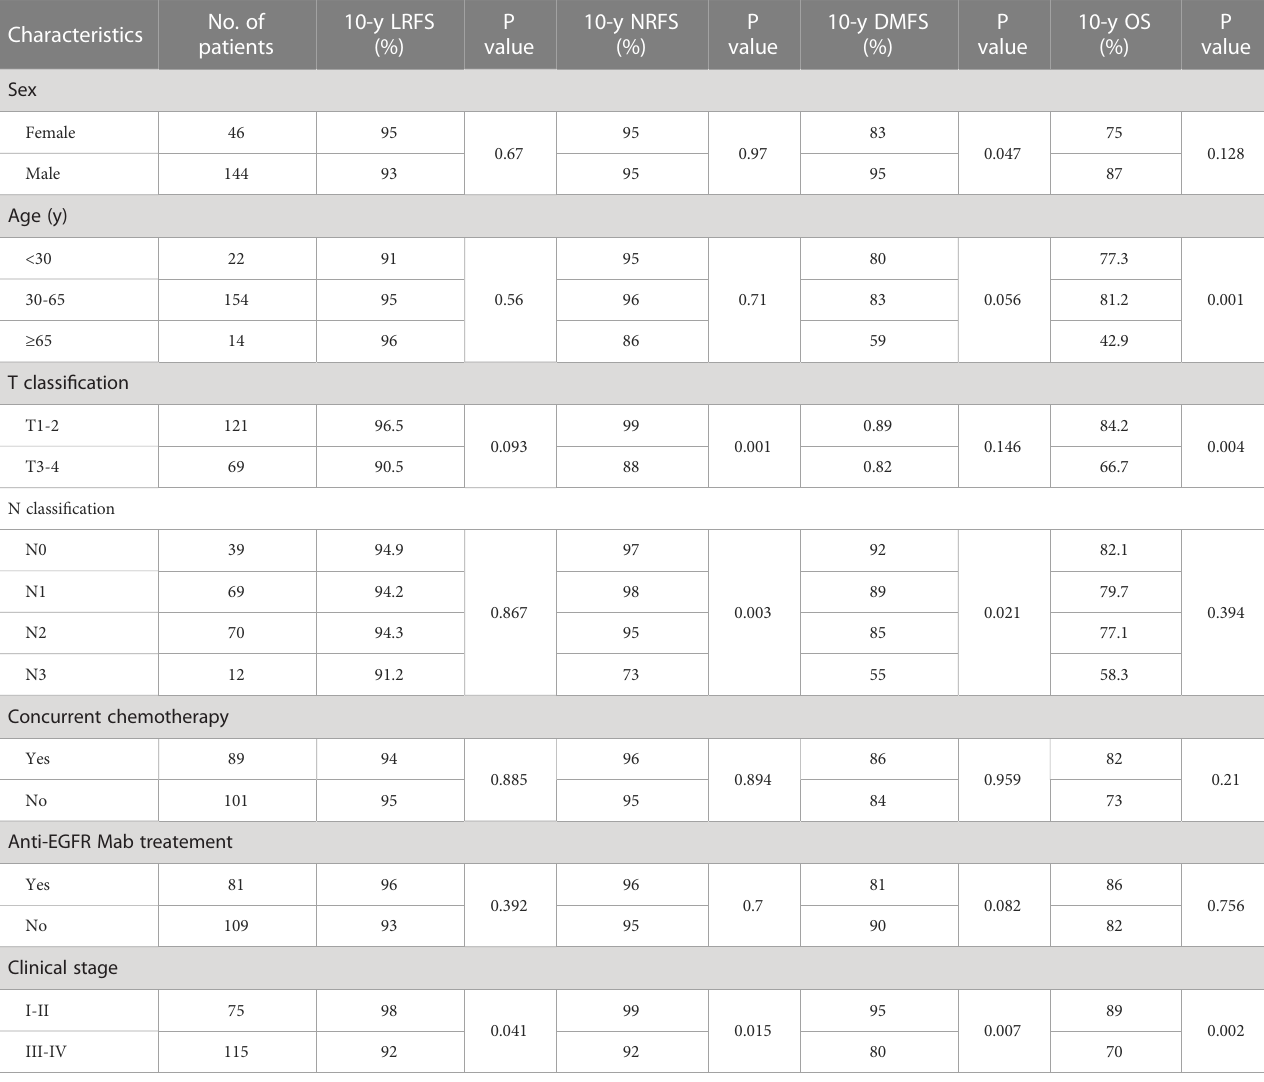
TABLE 2 Characteristics of 190 patients and univariate analysis of prognostic factors.